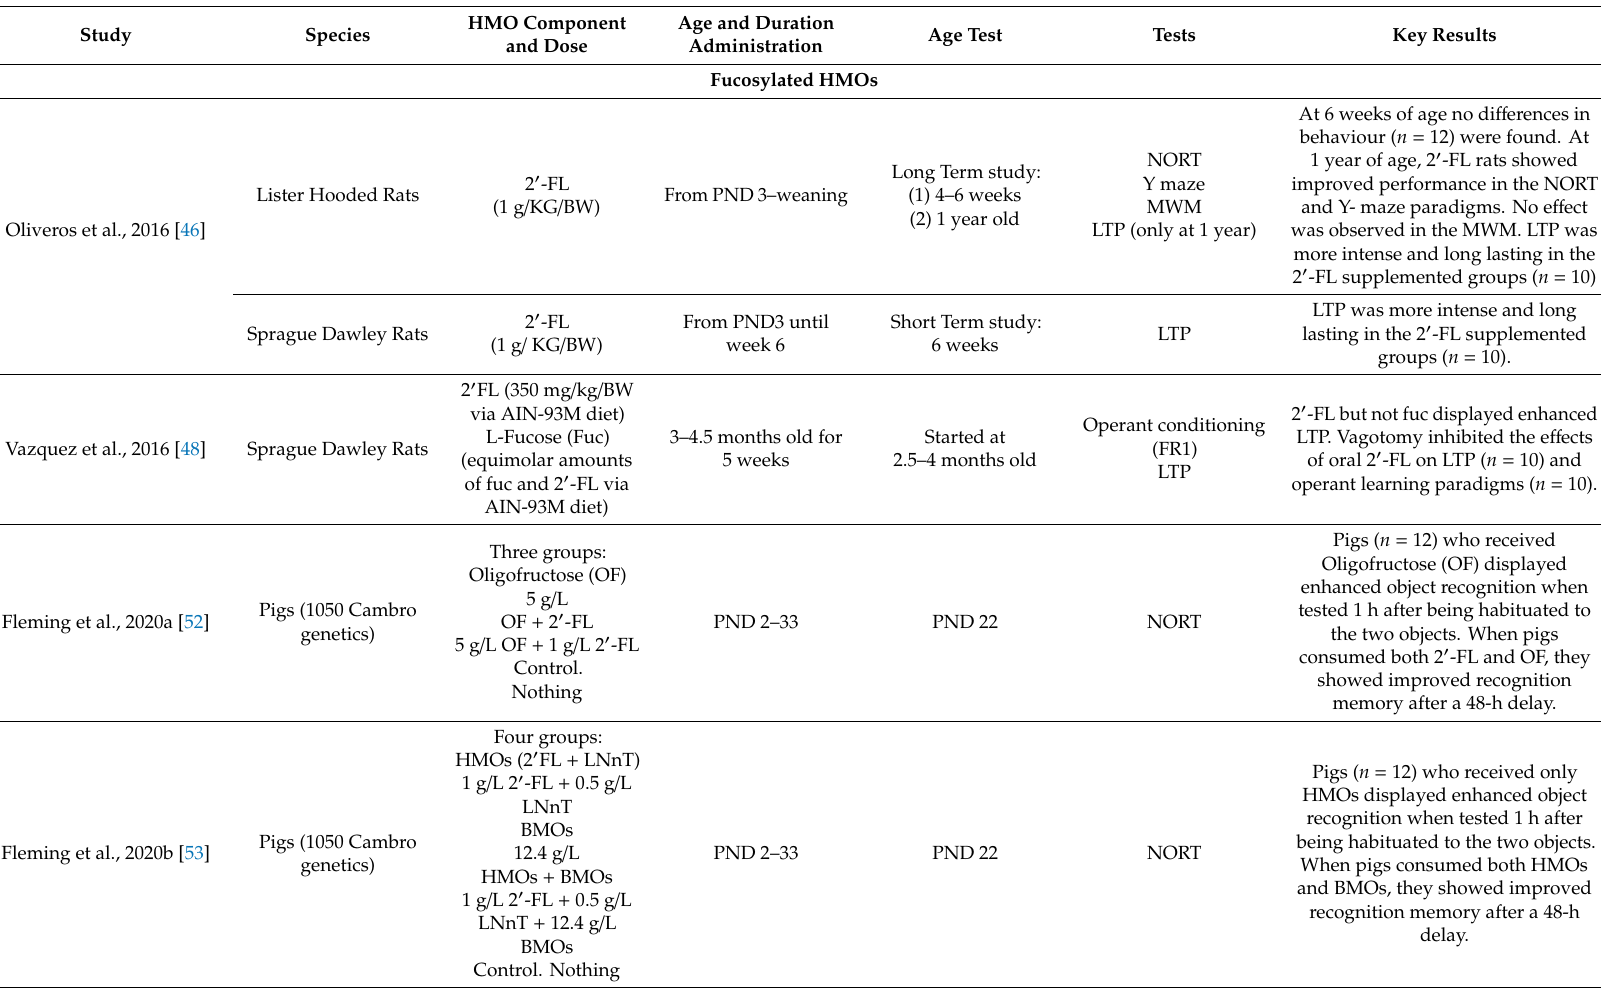
Table 1. Summary behavioural